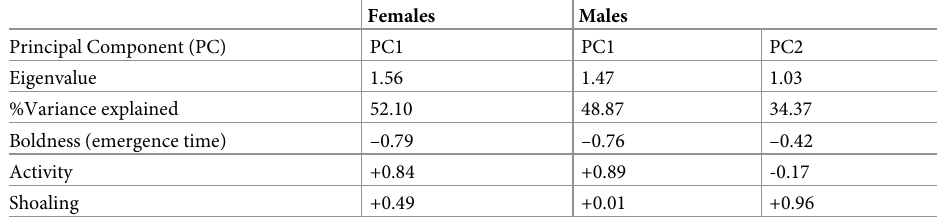
Table 1. Results of correlation matrix-based principal component analyses using three different personality traits as input variables. Females Males Principal Component (PC) PC1 PC1 PC2 Eigenvalue 1.56 1.47 1.03 %Variance explained 52.10 48.87 34.37 Boldness (emergence time) –0.79 –0.76 –0.42 Activity +0.84 +0.89 -0.17 Shoaling +0.49 +0.01 +0.96 PCAs were run for females and males, separately. Shown are axis loadings for PCs with eigenvalues >